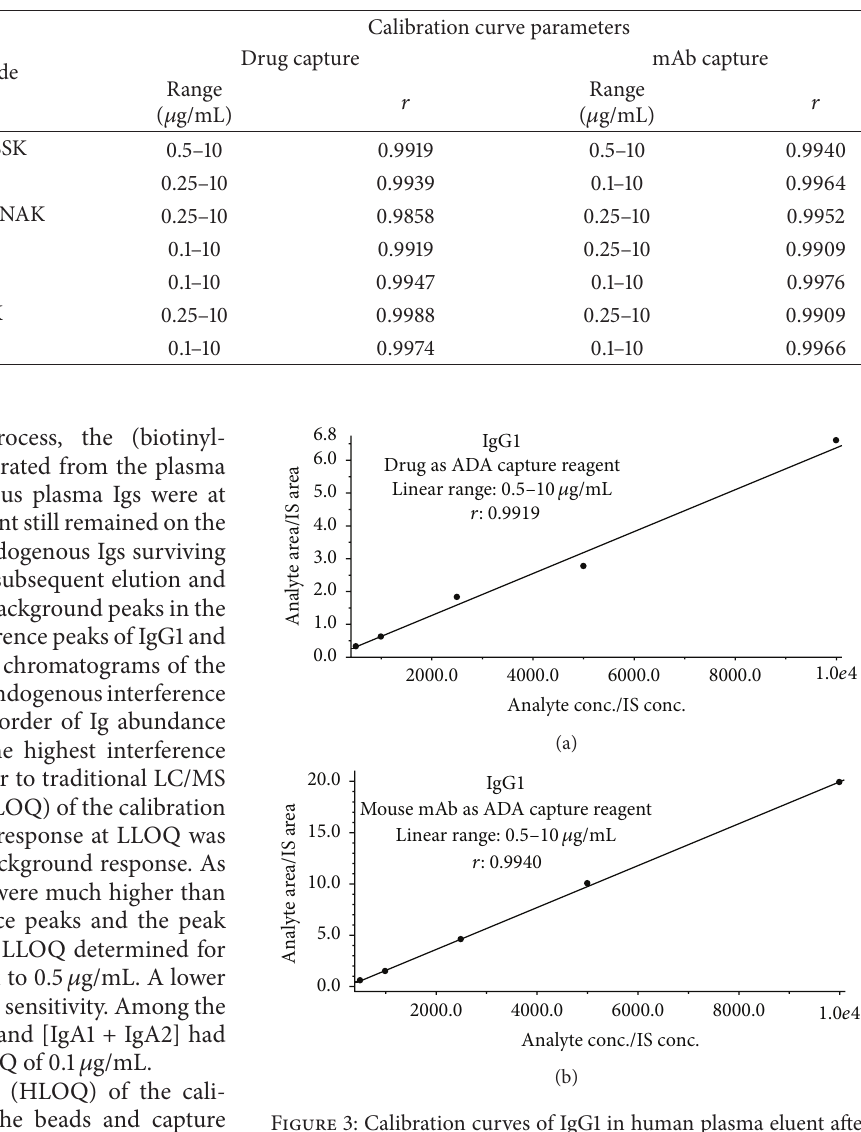
Table 4: Calibration curve ranges and regression coefficients ( 𝑟 ) of ADA isotype/subclasses using drug or mouse mAb as ADA capture reagent.